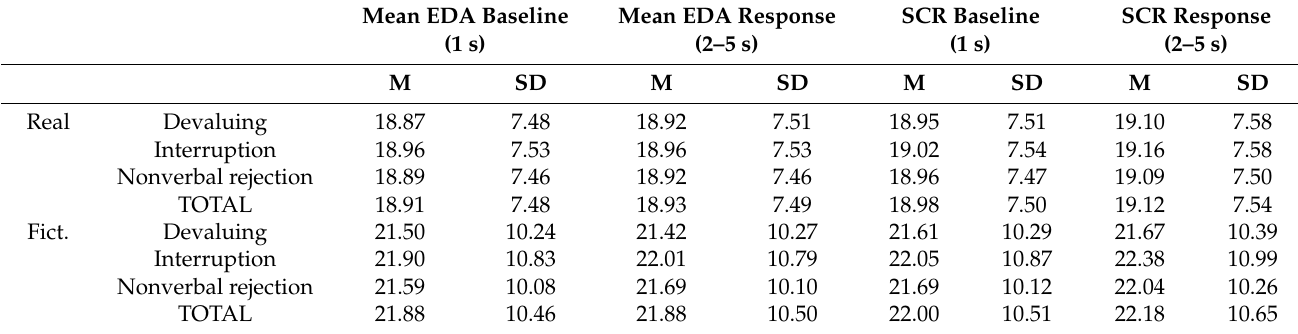
Table A2. Baseline Values and Social Rejection Responses